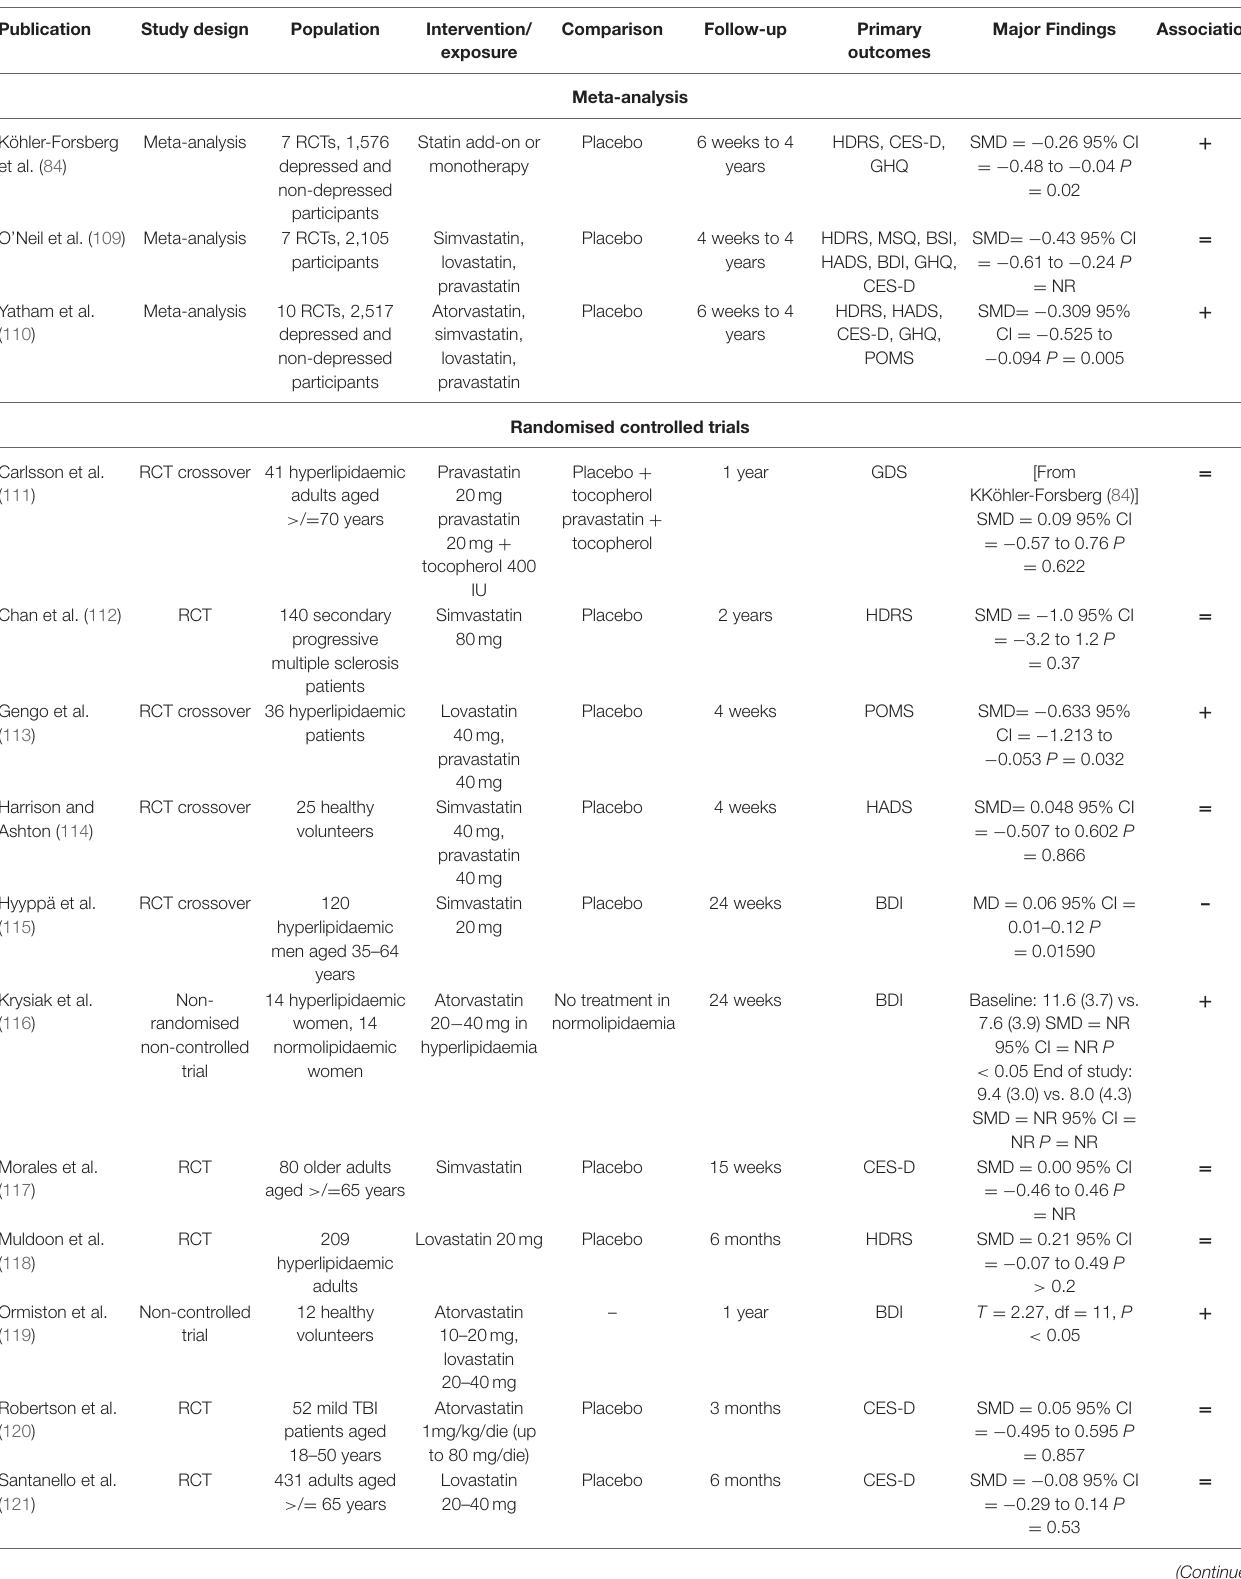
TABLE 2 | Overview of studies regarding the effects of statins on depressive symptoms scores in non-depressed